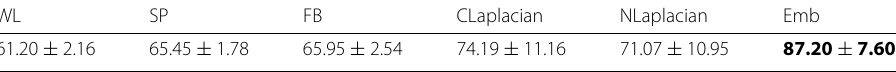
Table 4 Mean and standard deviation of classification accuracies on brain connectomes dataset